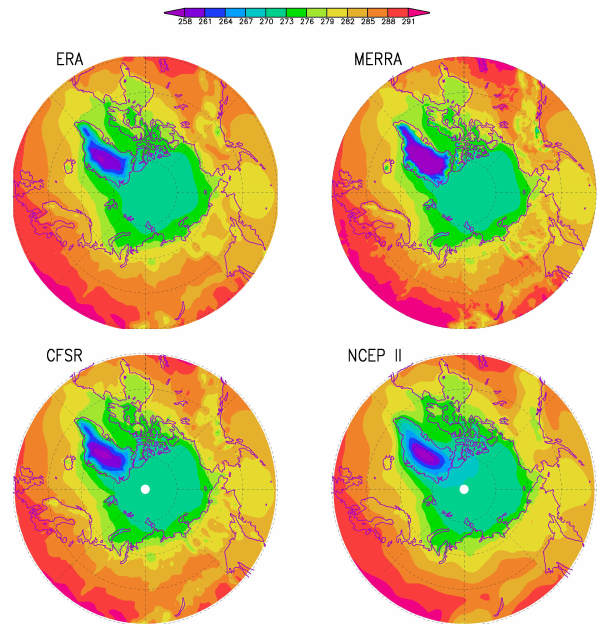
Fig. 1. June–August average surface air temperature climatology for the period 1979–2011 in units of K. In the case of CFSR, the climatology is for